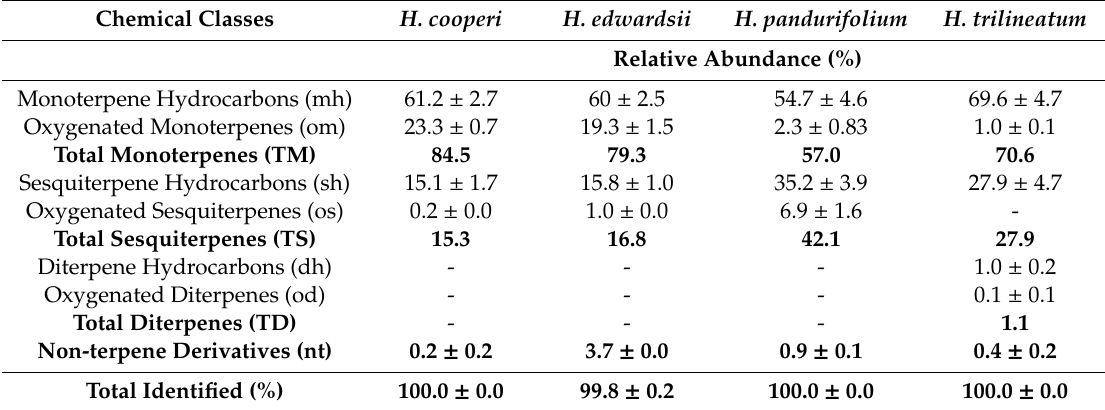
Table 2. Class of compounds in spontaneous emissions of the studied Helichysum spp.